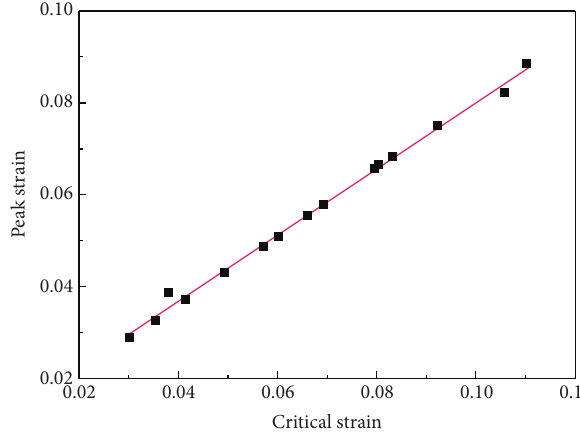
Figure 9: The relationships between 𝜀 𝑝 and 𝜀 𝑐